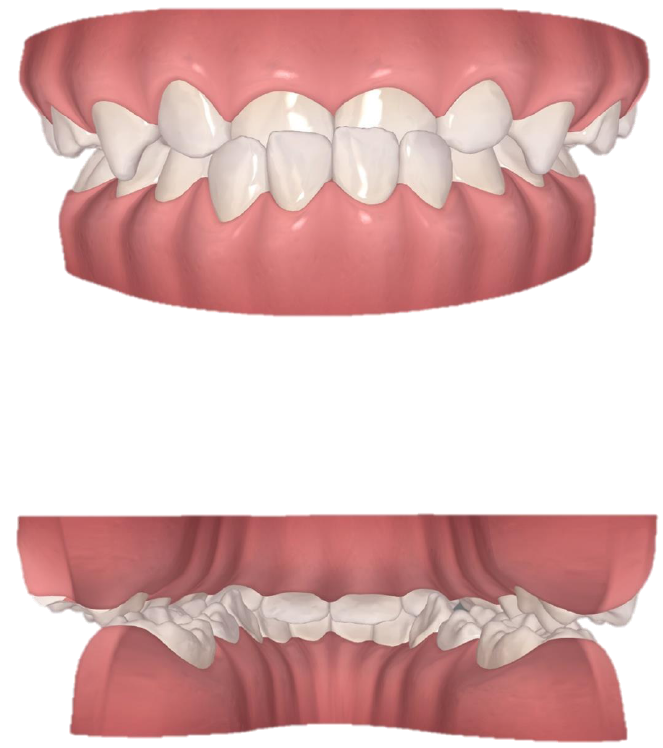
Figure 3. View of scissor bite details of the initial digital models.